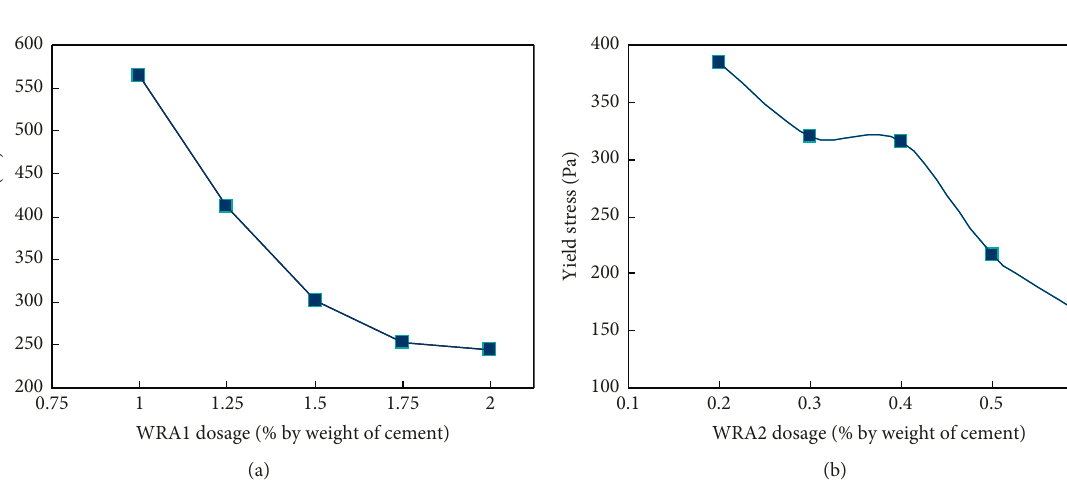
Figure 2: Shear yield stress of CGCBM mixed with different dosage of